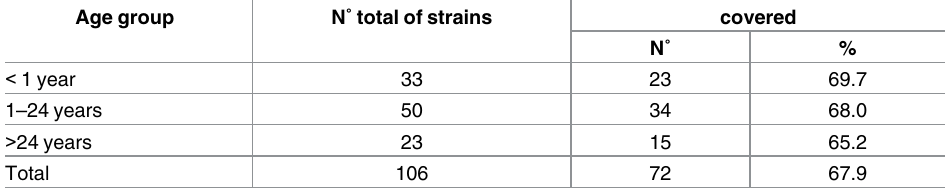
Table 4. Percentage of strain coveragepredicted by MATS by age